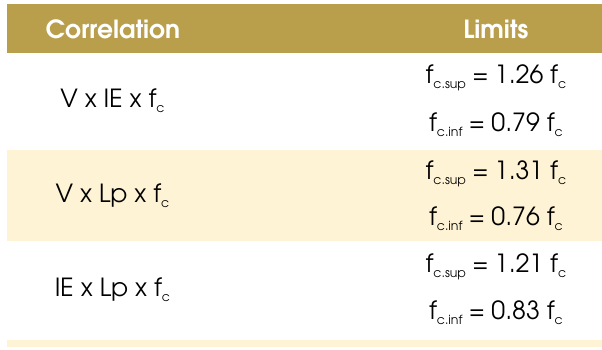
f – Values calculated from equations in table 5.